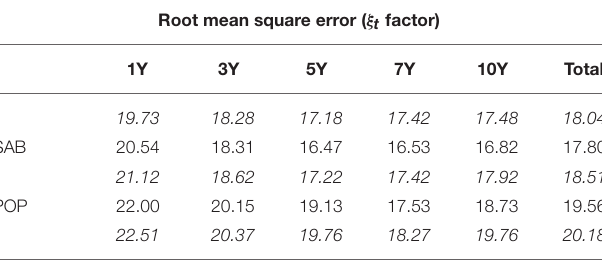
TABLE 3 | Calibration error of the multi-factor Vasicek